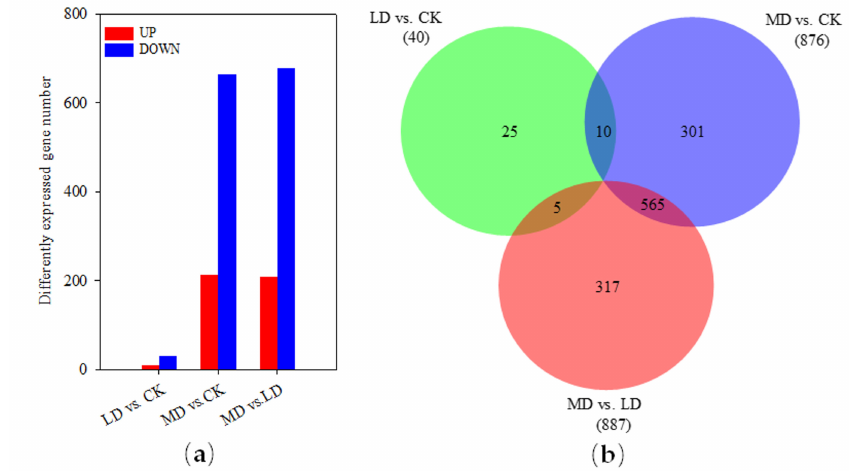
Figure 3. Identification and characterization of di ff erentially expressed genes (DEGs) between the drought treatment and control plants. ( a ) The number of DEGs in three comparison groups. ( b ) A Venn diagram comparison summarizing overlaps in di ff erentially expressed genes among the three